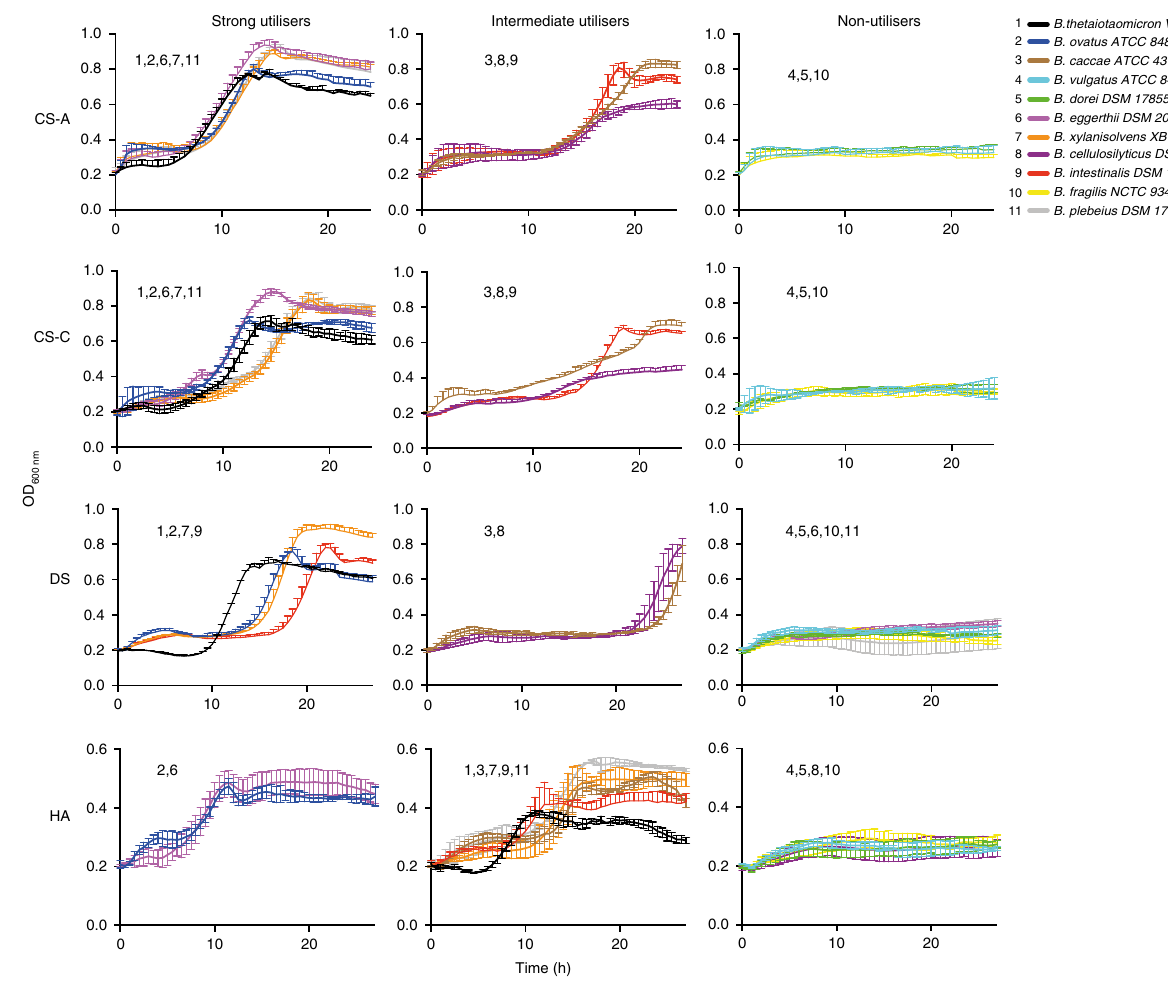
Fig. 6 Growth curves of 11 bacteroides species on CS-A, DS, CS-C and HA. The different species were divided into strong, intermediate and non-utilisers based on analysis of growth curve rates and fi nal optical densities. Data represent technical triplicates and source data are provided in the source data fi le labelled as strain